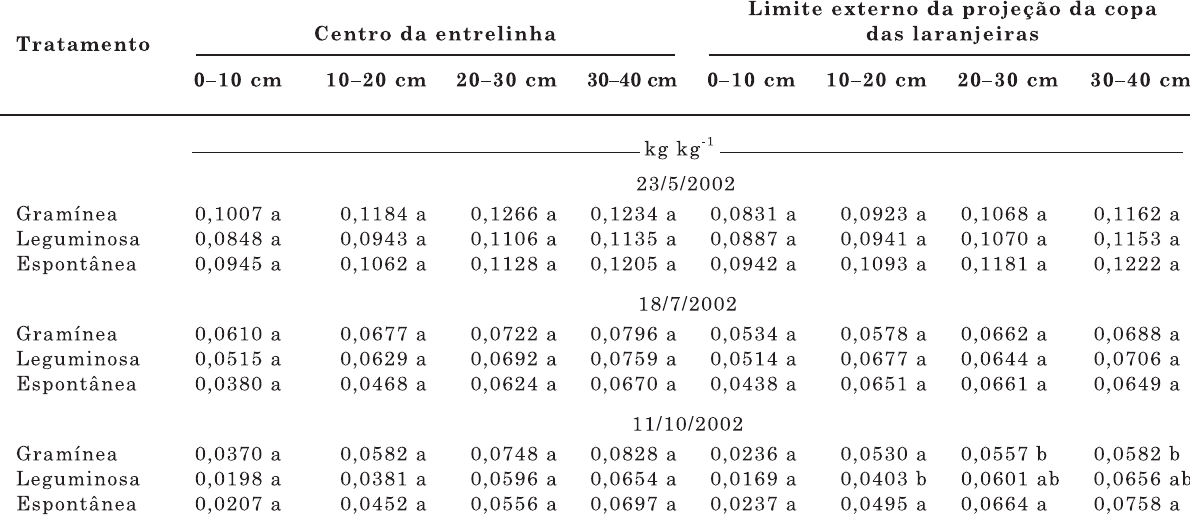
de mamoeiro com irrigação pode ter sido a causa da competição por água, reduzindo a sua produtividade. da água nas folhas das laranjeiras (Quadro